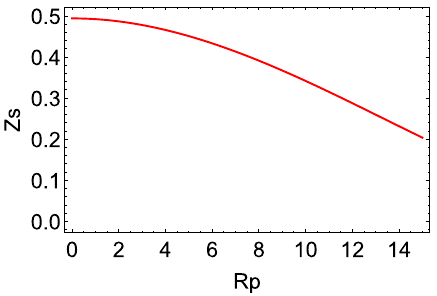
Fig. 11 Variation of mass with radial coordinate